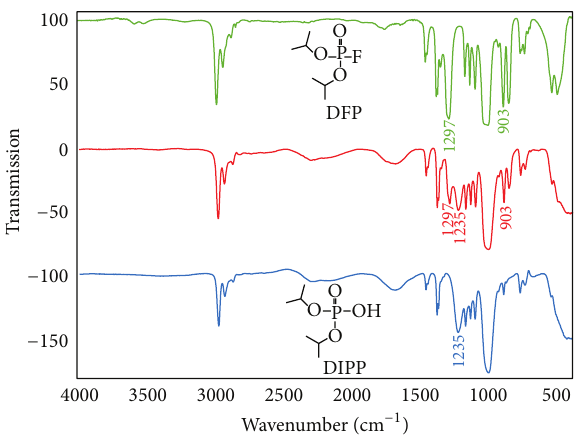
Figure 7: FT-IR spectra of pure DFP (top), partially degraded commercial DFP (middle), and a pure DIPP standard (bottom).